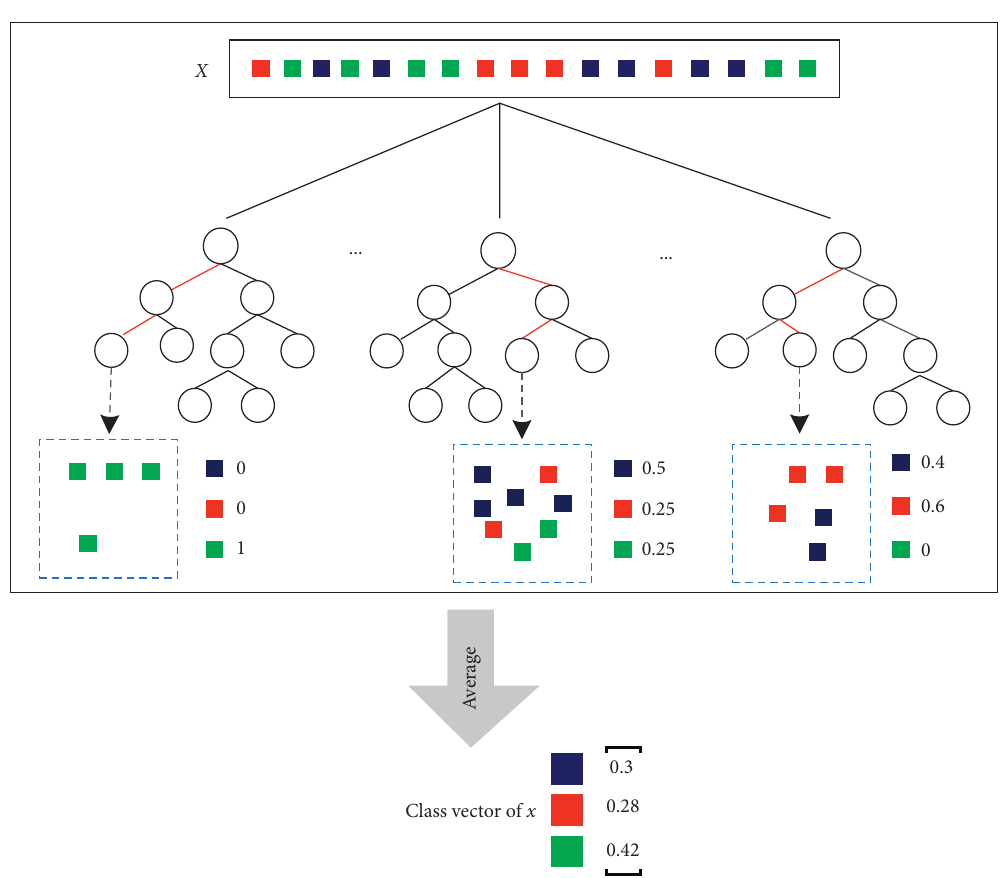
Figure 9: The classification process of training